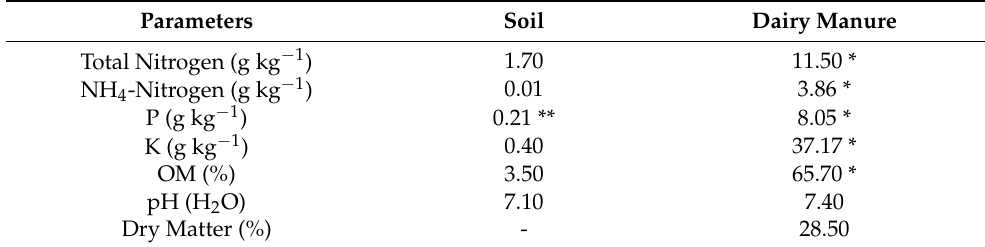
Table 1. Soil and dairy manure parameters (mean, n = 3).